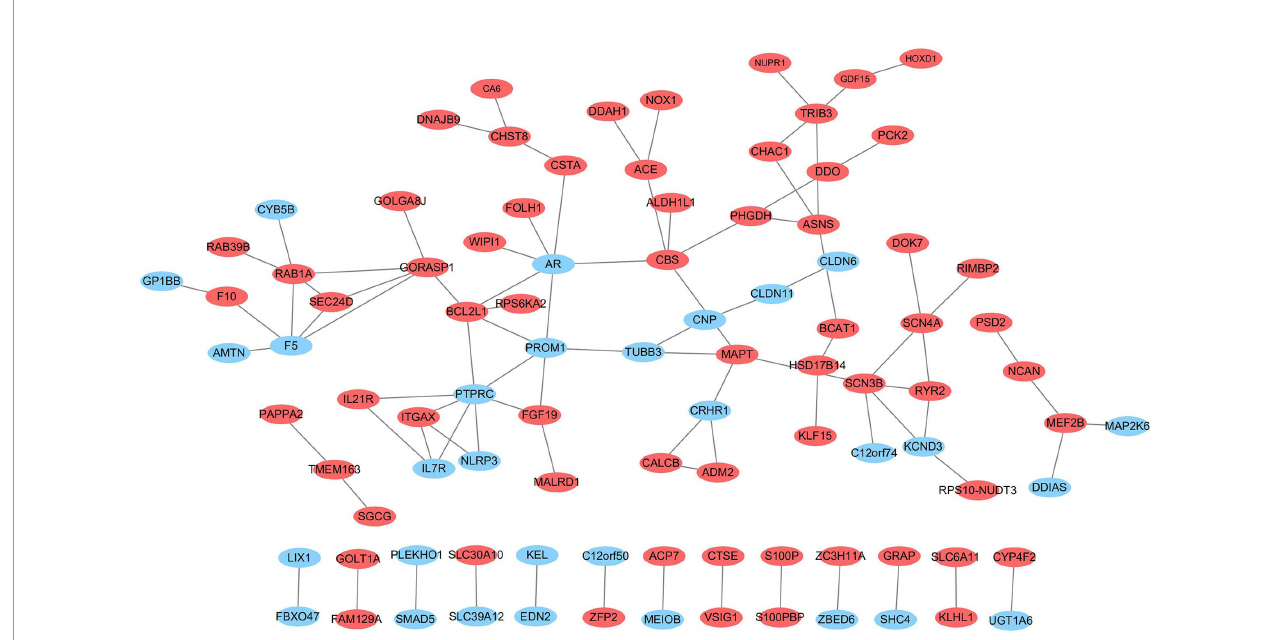
FIGURE 9 | The network of protein-protein interactions (PPI) of differentially expressed genes. Red and blue represent up- and down-regulation,